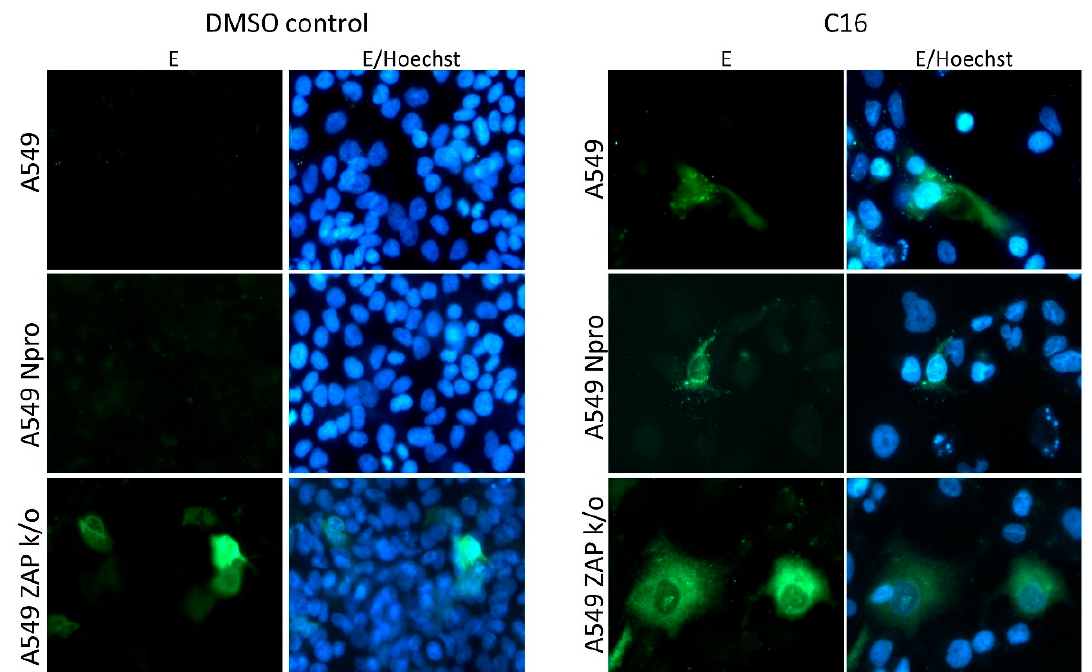
Figure 4. BinJV envelope expression in human cells can be established by kinase inhibitor C16 and not IRF3/7 degradation. A549 cells, ZAP k/o cells and A549 NPro expressing cells infected with BinJV and either treated with kinase inhibitor C16 or DMSO as a control. Cells were fixed and stained for BinJV envelope (E) with BJ-6E6 monoclonal antibodies (green) and nuclei stained with Hoechst 33342 (blue). Microscopic images were taken using a Zeiss Axio Observer Z1m inverted microscope with an LD Plan-Neofluar 40×/0.6 Ph2 korr objective.